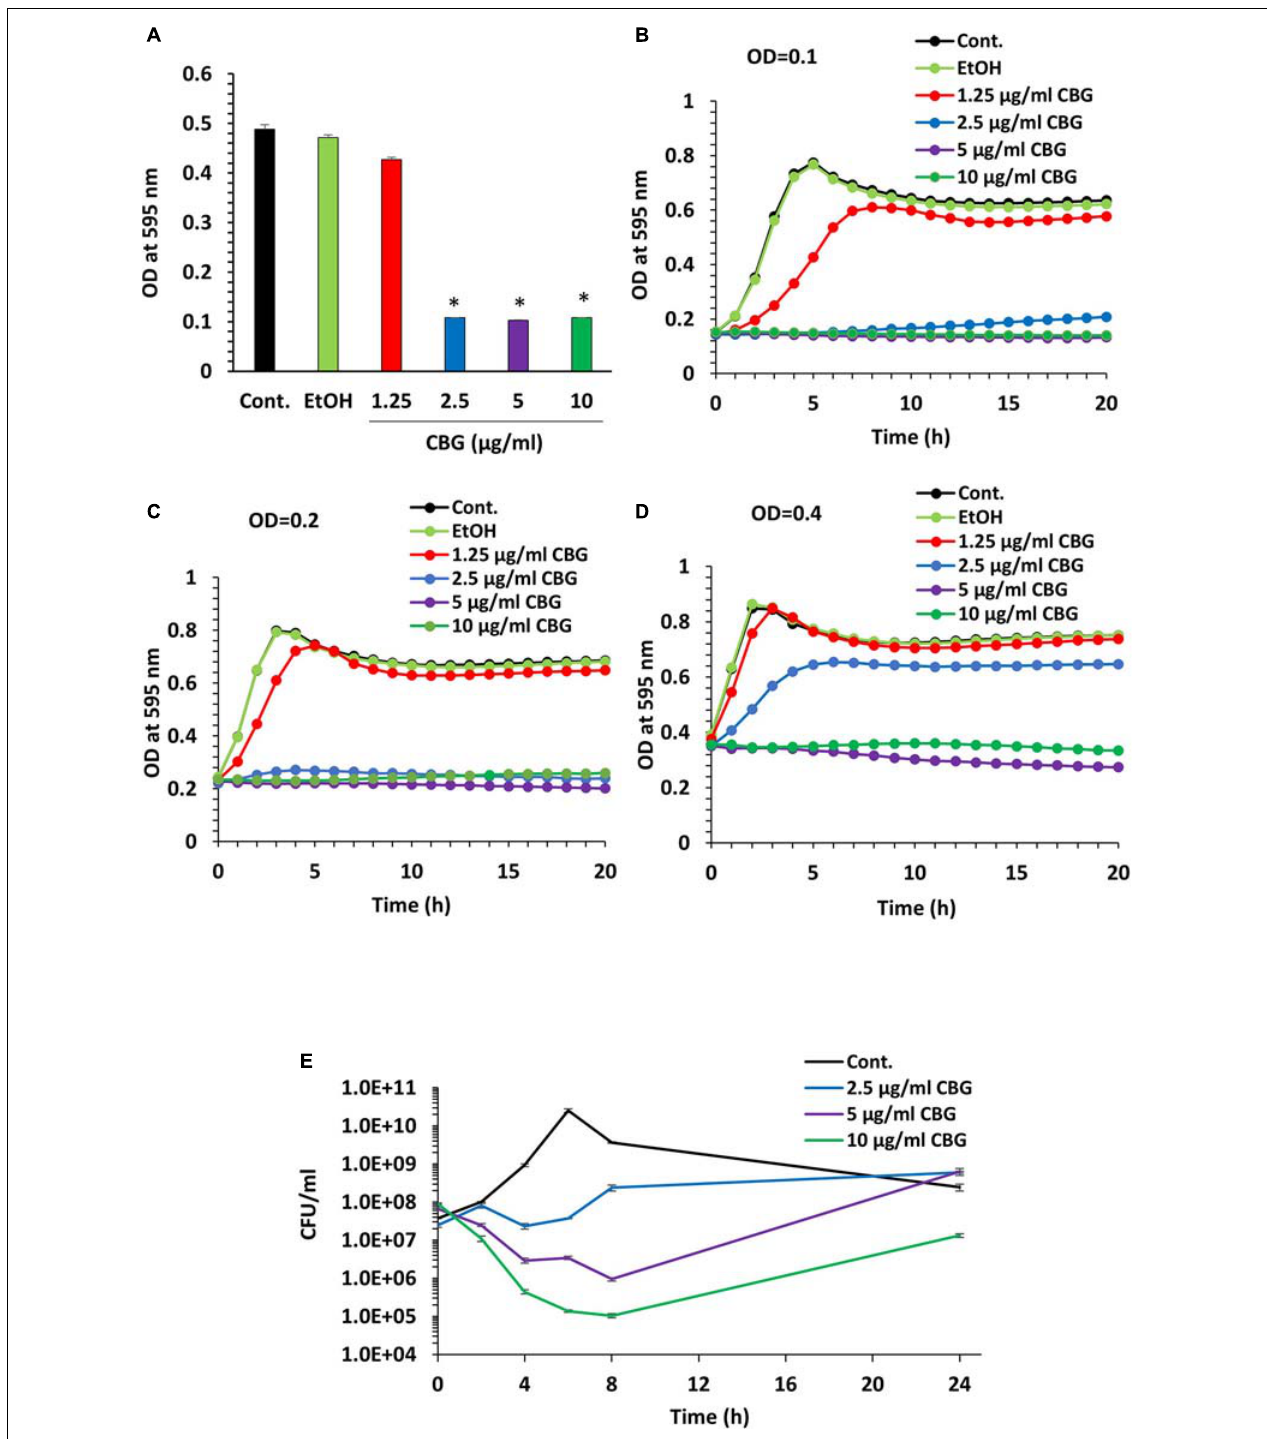
FIGURE 1 | CBG halts the proliferation of planktonic growing S. mutans . (A) The viability of S. mutans after a 24 h incubation with increasing doses of CBG (0–10 µ g/ml) as measured by OD 595 nm . n = 3; * p < 0.05. (B–D) A kinetic study of the planktonic growth of S. mutans in the presence of increasing concentrations of CBG (0–10 µ g/ml) at starting OD 600 nm = 0.1 (B) , 0.2 (C) , and 0.4 (D) . (E) The colony forming units of untreated and CBG (0–10 µ g/ml)-treated bacteria at various time points. n =